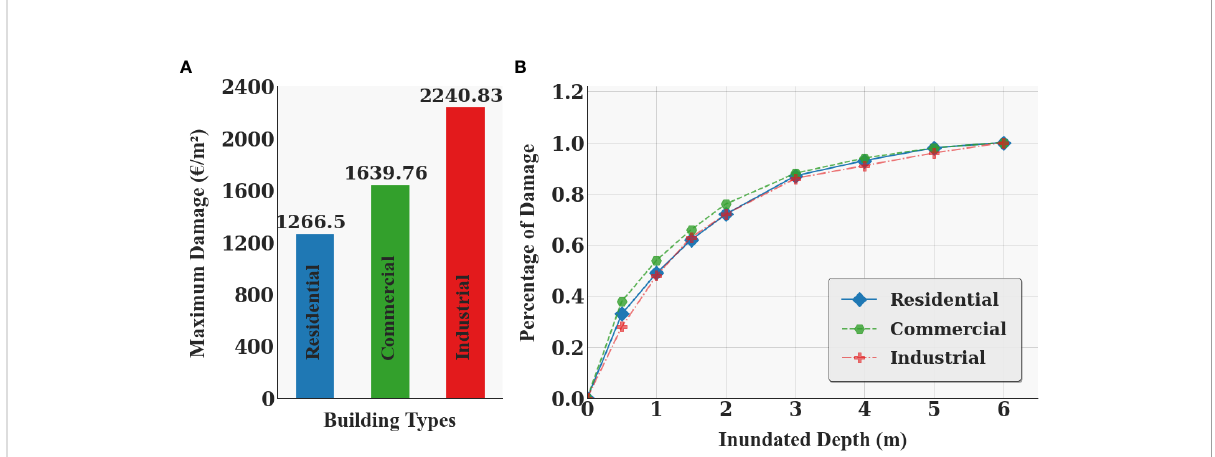
FIGURE 6 Depth – damage curves for different types of buildings. (A) The maximum monetary damage per square meter for Chinese buildings. (B) Relative depth-damage curves relate the damage fraction to the inundation depth.